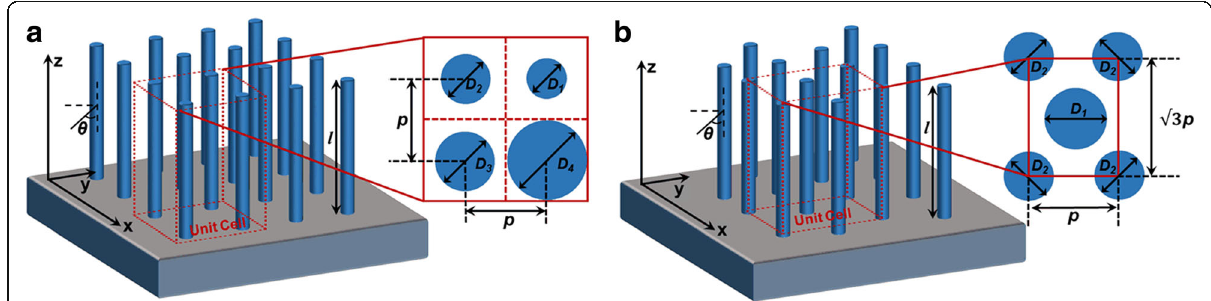
Fig. 1 Schematics of vertically aligned InP NW arrays. a Squarely and b hexagonal NW arrays with insets explaining their respective unit